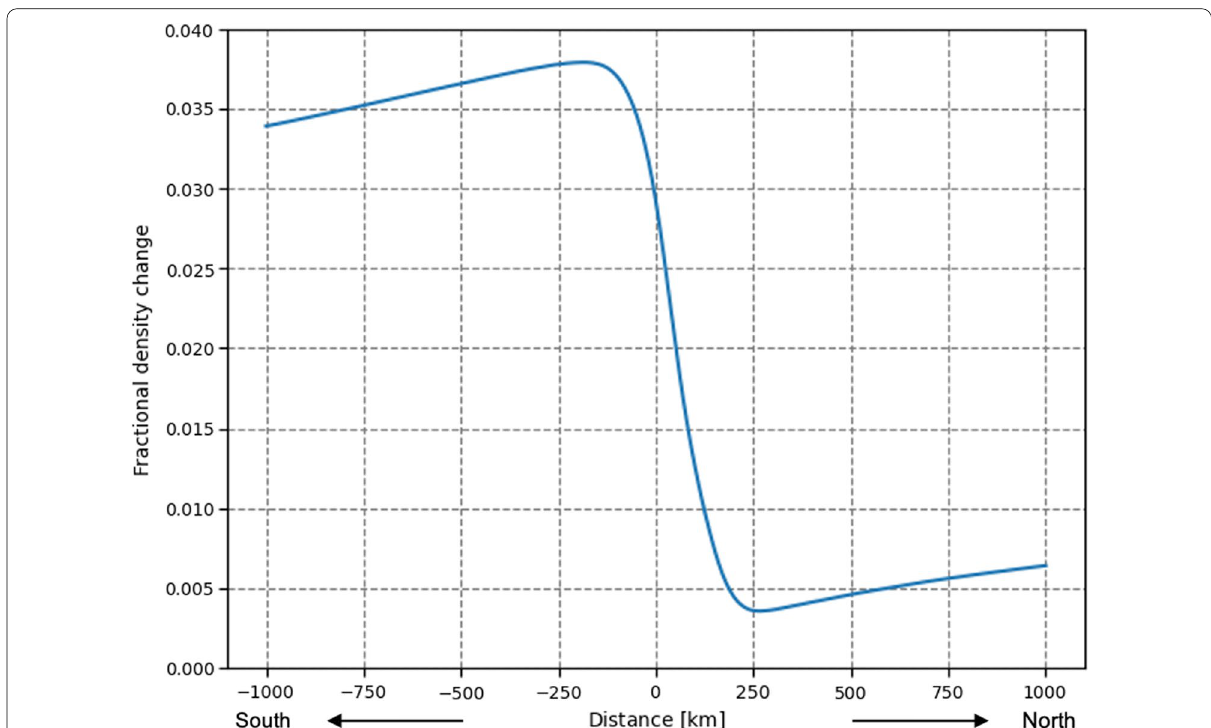
Fig. 6 Fractional density change at 250 km altitude in Case 1. The difference between the maximum and minimum is